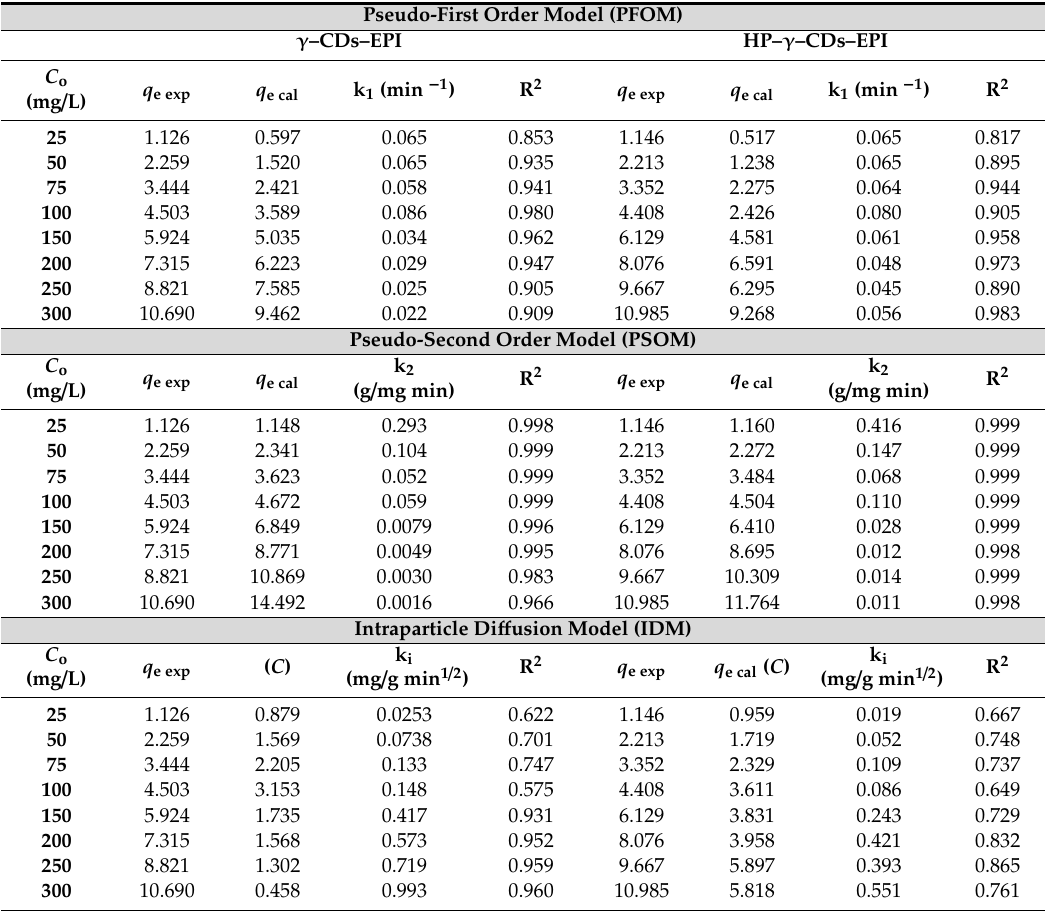
Figure 6. Pseudo-first order model analysis for both adsorbents and different DR concentrations (25 mg/L (●), 50 mg/L ( ○ ), 75 mg/L ( ■ ), 100 mg/L (□), 150 mg/L ( ▲ ), 200 mg/L (Δ), 250 mg/L ( ♦ ) and 300 mg/L ( ⟡ )). Experimental conditions: adsorbent = 1g, pH = 7, speed = 500 rpm, contact time = 120 min, dye concentration = 25–300 mg/L. Table 2. Kinetics results for the three models analysed.